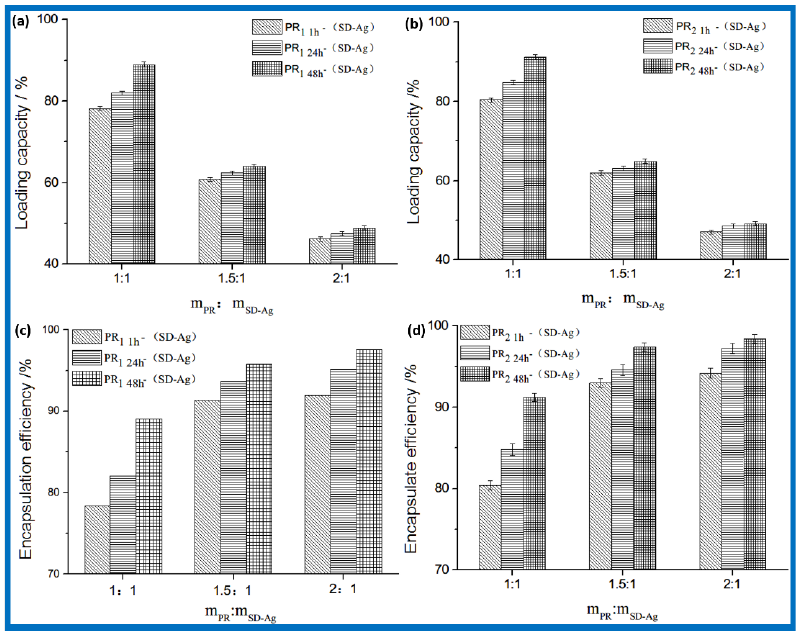
Figure 2. The drug loading capacity of ( a ) PR 1 t -(SD-Ag), ( b ) PR 2 t -(SD-Ag), and the encapsulation efficiency of ( c ) PR 1 t -(SD-Ag), ( d ) PR 2 t -(SD-Ag).